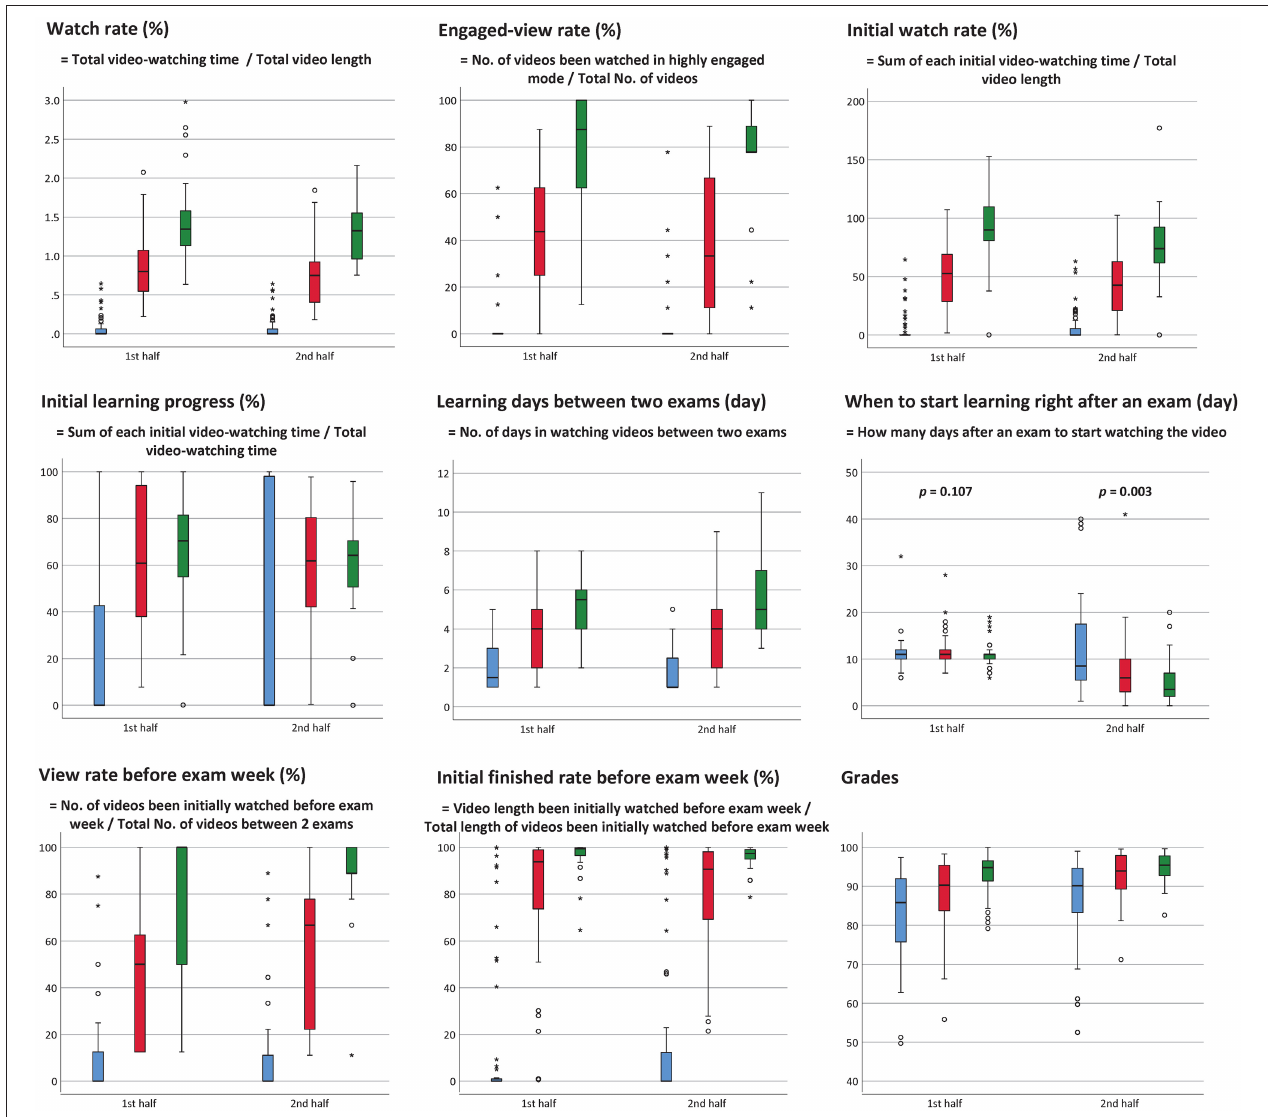
FIGURE 3 | Online video-watching characteristics among the 3 groups with different engagement levels ( p < 0.001 for all unless otherwise mentioned) (Abbreviation: No., number). *represents extreme value; ◦ represents potential